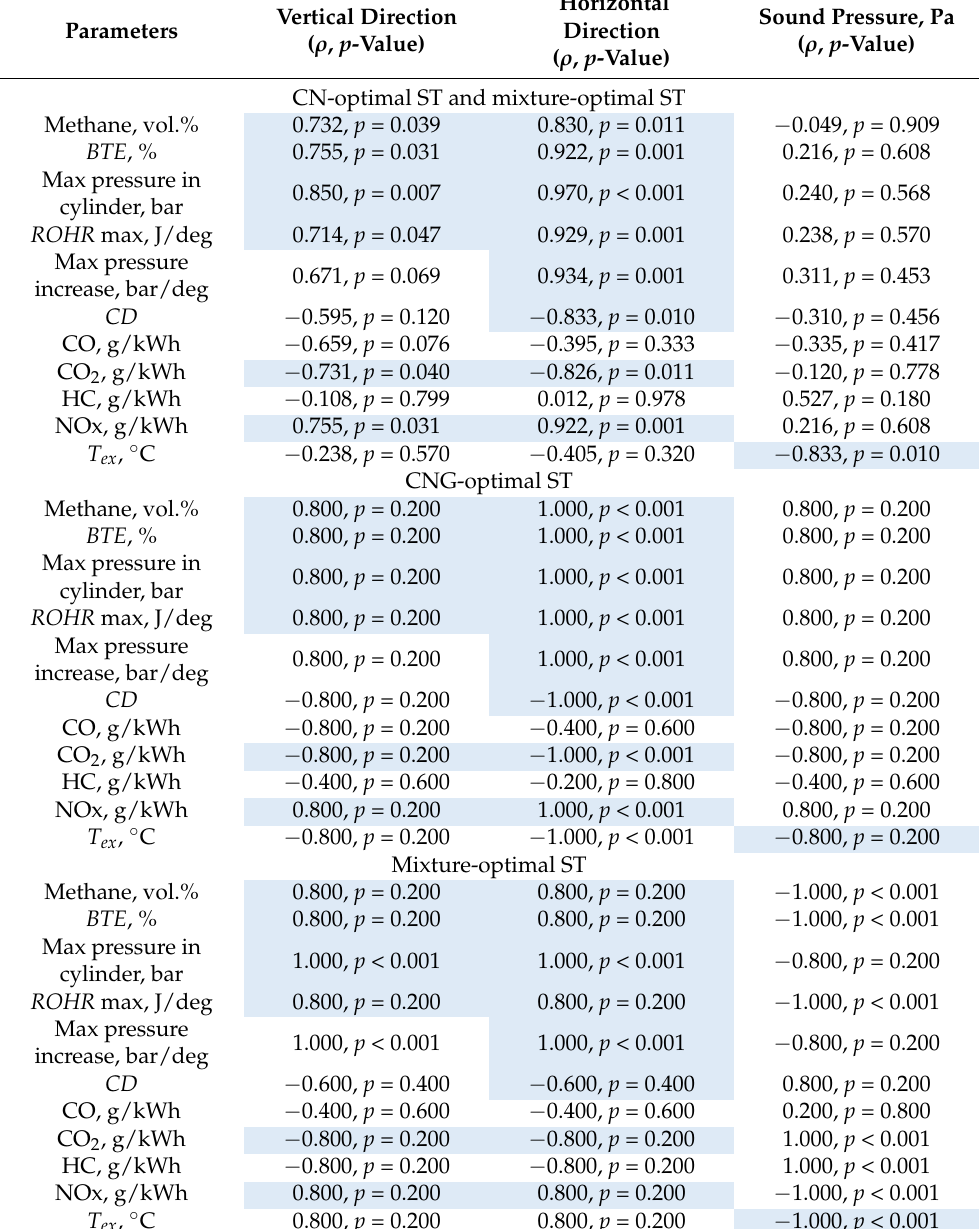
Table 9. Comparison of vibration, sound pressure and emission parameters